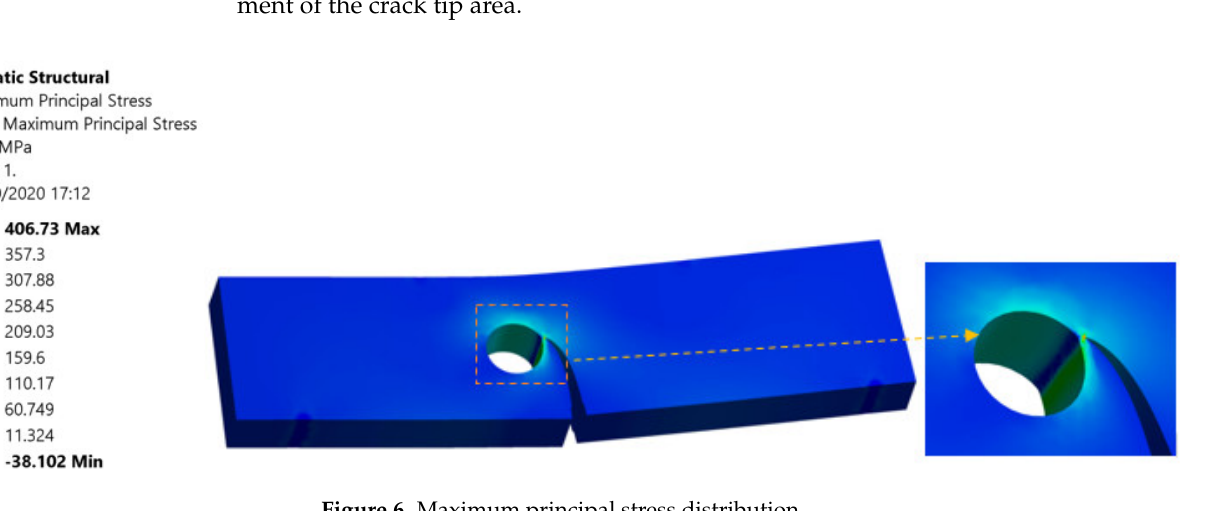
Figure 5. Von Mises stress distribution for the last step of the crack growth with and without deformation. The distribution of the maximum principal stress is shown in Figure 6 with enlarge- ment of the crack tip area.